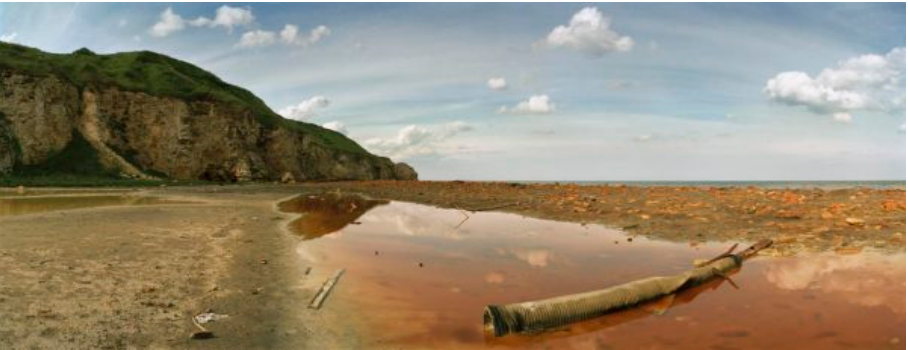
Figure 4. Sirkka-Liisa Konttinen, Hawthorn Hive, afternoon 31 May 2000. Pool of water on a raised plateau of pit waste; piece of flexipipe; boulders coloured with iron oxides (2000), from The Coal Coast series. ©Sirkka-Liisa Konttinen, courtesy Amber/L Parker Stephenson Photographs.